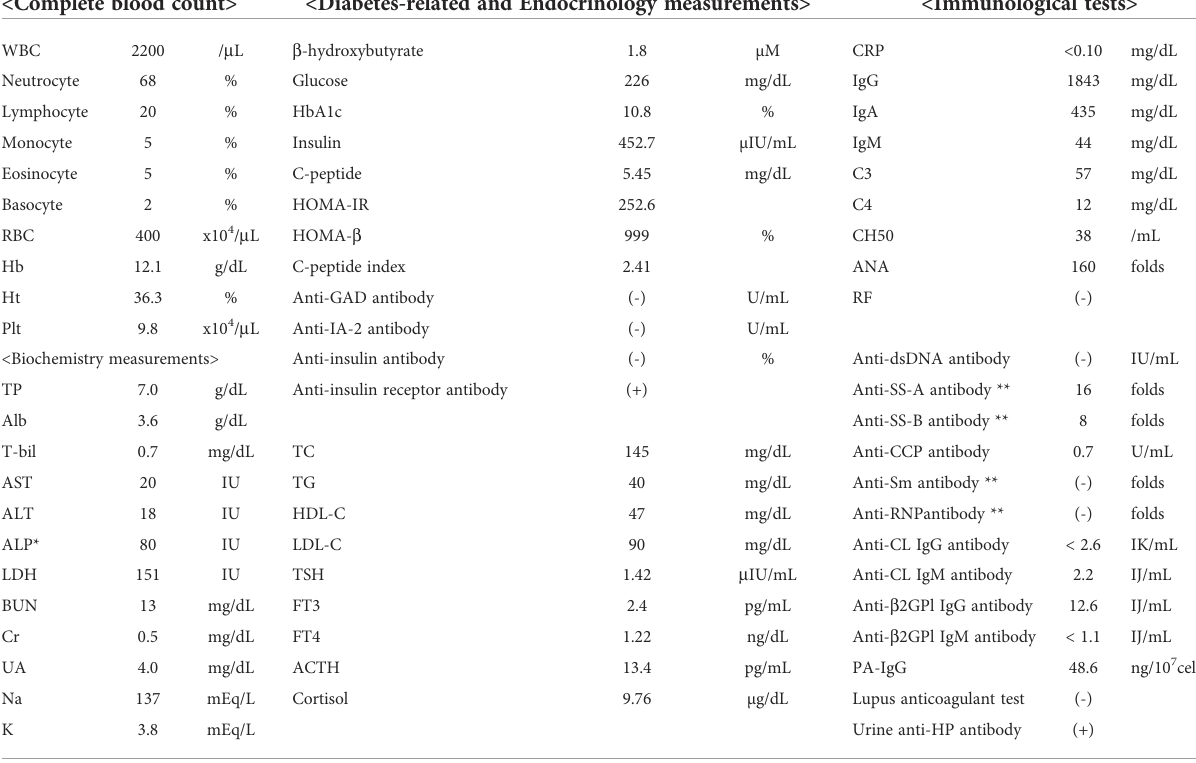
TABLE 1 Laboratory fi ndings on admission.